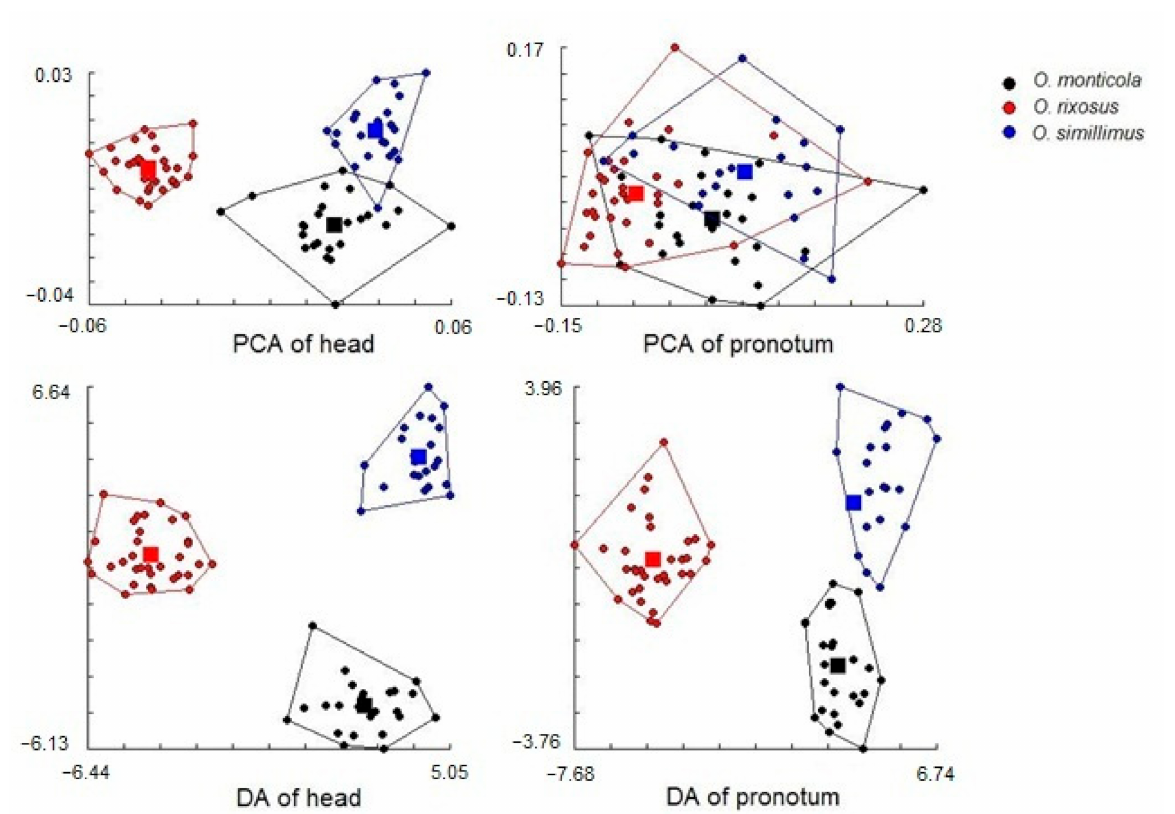
Figure 6. Top: Factor maps of the two first principal components (PC1 as the horizontal axis) of head ( left ) and pronotum ( right ) shape variables Bottom: Factor maps of the two discriminant factors (DF1 as the horizontal axis, DF2 as the vertical one) derived from the 7 first PC of shape variables of head ( left ) and pronotum ( right ). Each point represents an individual ant sample of either O. monticola , O. simillimus , or O. rixosus , and each a posteriori polygon corresponds to a different species. Squares represent mean values in each